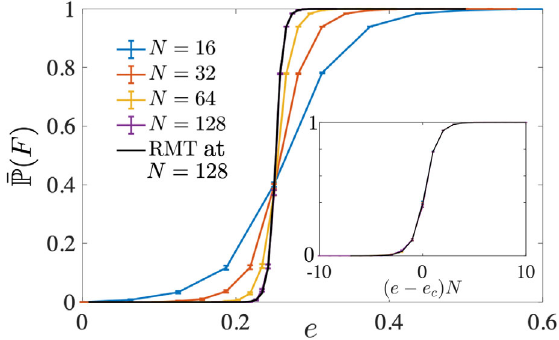
FIG. 3. Toy model for the below-threshold behavior of finite- depth, random, unitary-encoding circuits in which we remove gates that couple different blocks of FIG. 2. Failure probability for 1D circuit of depth N with periodic boundary conditions obtained via numerically sampling 10 3 random codes. We take a fixed fraction erasure error at a code N= 4 . The rate R ¼ 1 = 2 , for which the critical erasure rate is e c ¼ black line shows the RMT prediction computed for N ¼ 128 , which agrees with the numerical results to within the statistical error bars. The inset shows an excellent collapse for this full range of sizes according to the predicted scaling.